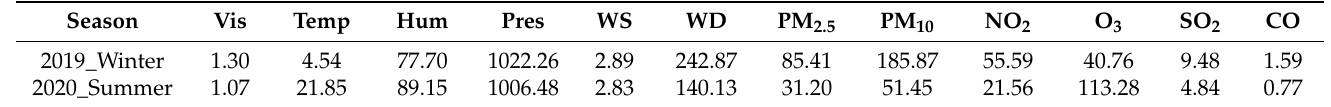
Table 5. Statistics on the mean values of meteorological parameters and pollutant parameters